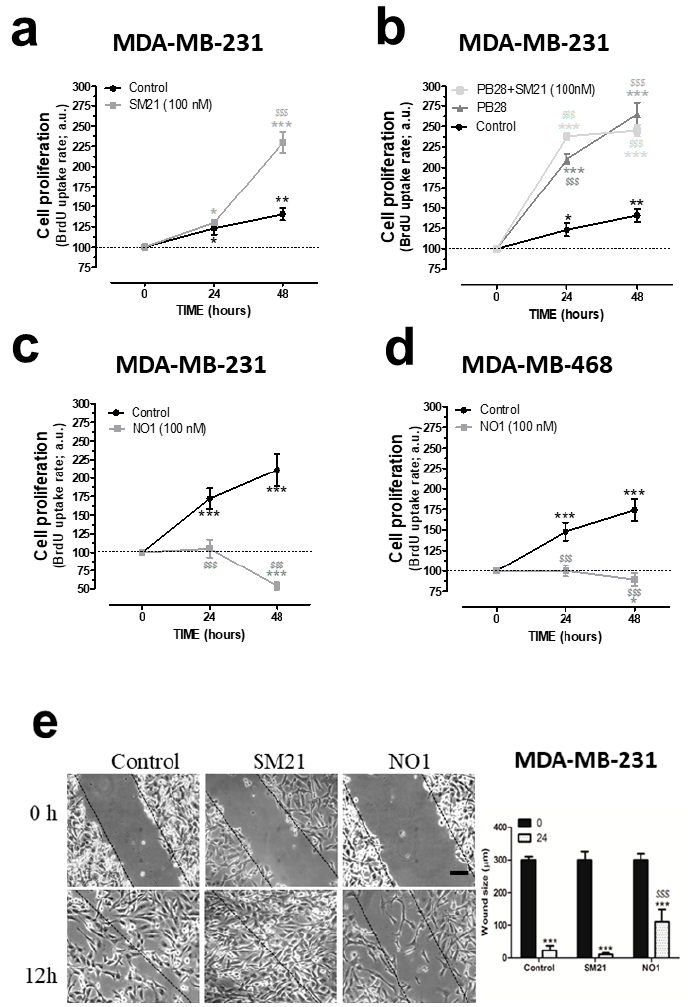
Figure 2. σ 2R / TMEM97 is involved in the proliferation and migration of triple negative breast cancer cell lines (TNBC) cells. ( a ) MDA-MB-231 cells were shed onto coverslips (0.5 × 10 6 cells / mL), and at day 0, the cell culture was supplemented with either the vehicle control, ( a – d ), SM21, 100 nM, ( a , b ), PB28 (1 nM, dark-grey trace, ( b ), dark grey trace) and a combination of PB28 + SM21 (( b ), light-grey trace). Cells were cultured for at least 48 h under normal growing condition (37 °C and 5% CO 2 in the incubator). Alternatively, TBNC cell lines, MDA-MB-231 ( c ) and MDA-MB-468 cells ( d ) were grown for